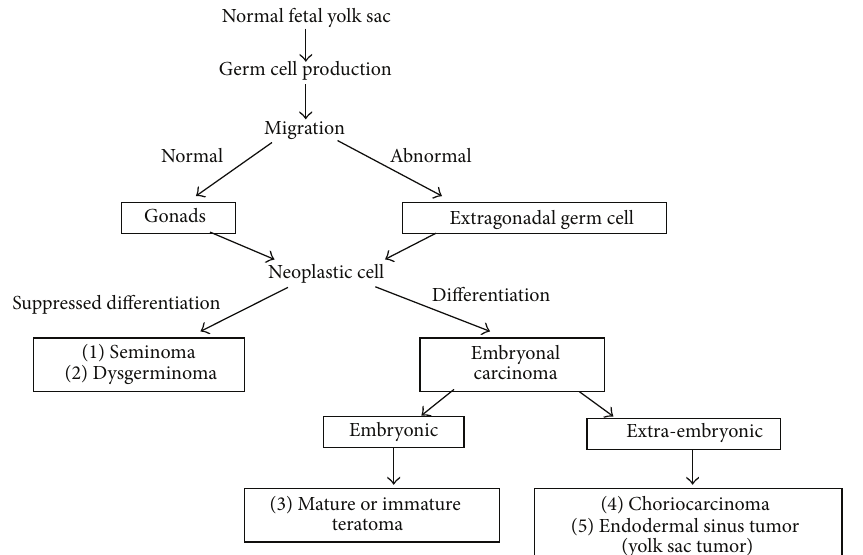
Figure 1: Development of germ cell tumors.